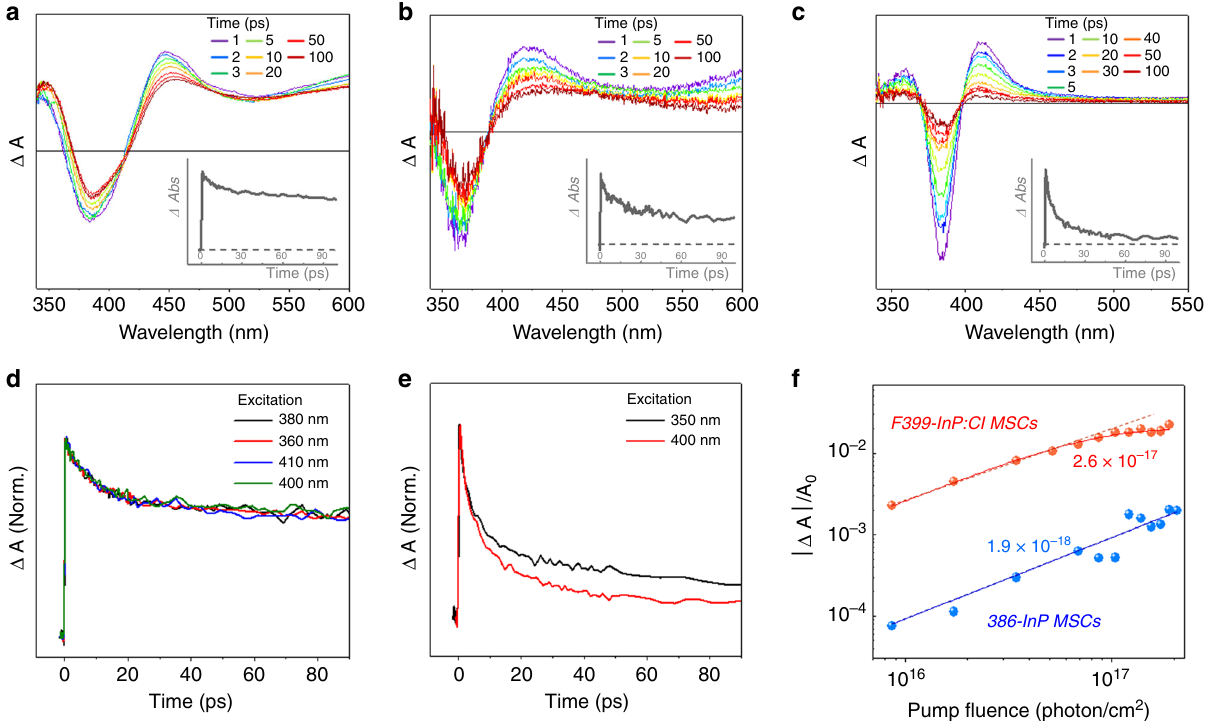
Fig. 6 Optical characterizations of InP:Cl MSCs. Transient absorption (TA) spectra of a 386-InP MSCs (inset: TA decay pro fi le at 445 nm), b F360-InP:Cl MSCs (inset: TA decay pro fi le at 410 nm), and c F399-InP:Cl MSCs in toluene (inset: TA decay pro fi le at 410 nm). TA decay pro fi les of d 386-InP MSCs at 450 nm and e F399-InP:Cl MSCs at 410 nm with various excitation-wavelength. f Plot for normalized LEET bleach signals of 386-InP MSCs and F399-InP:Cl MSCs with the estimated absorption cross-section value σ abs (cm − 1